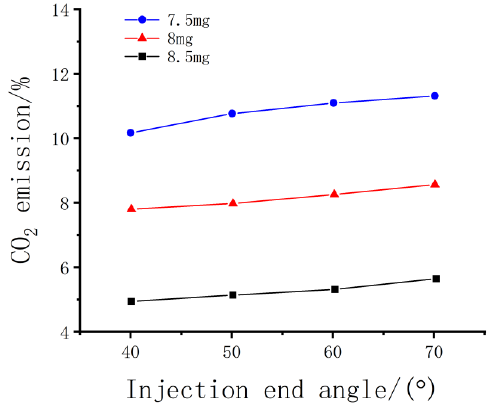
Figure 36. Effect of the injection parameters on CO 2 emissions.